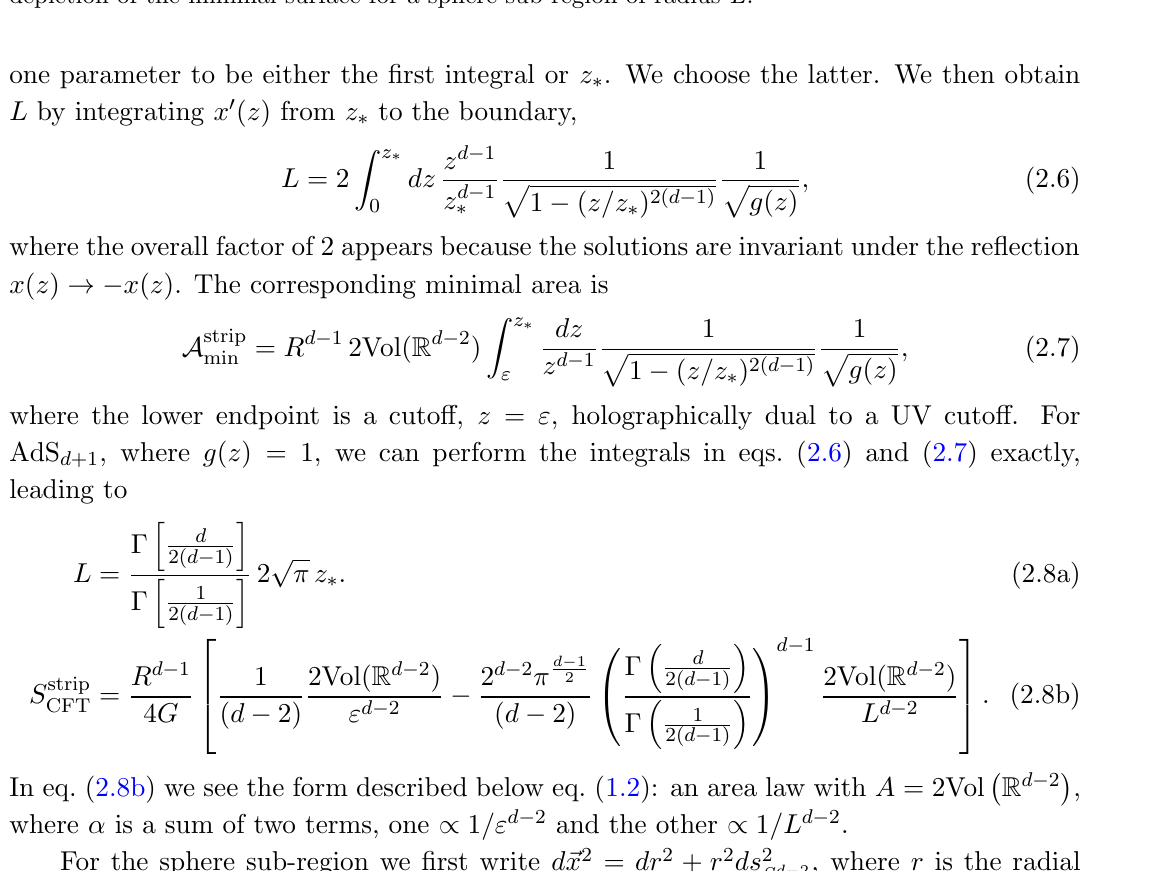
. (b) Similar schematic (cid:3)